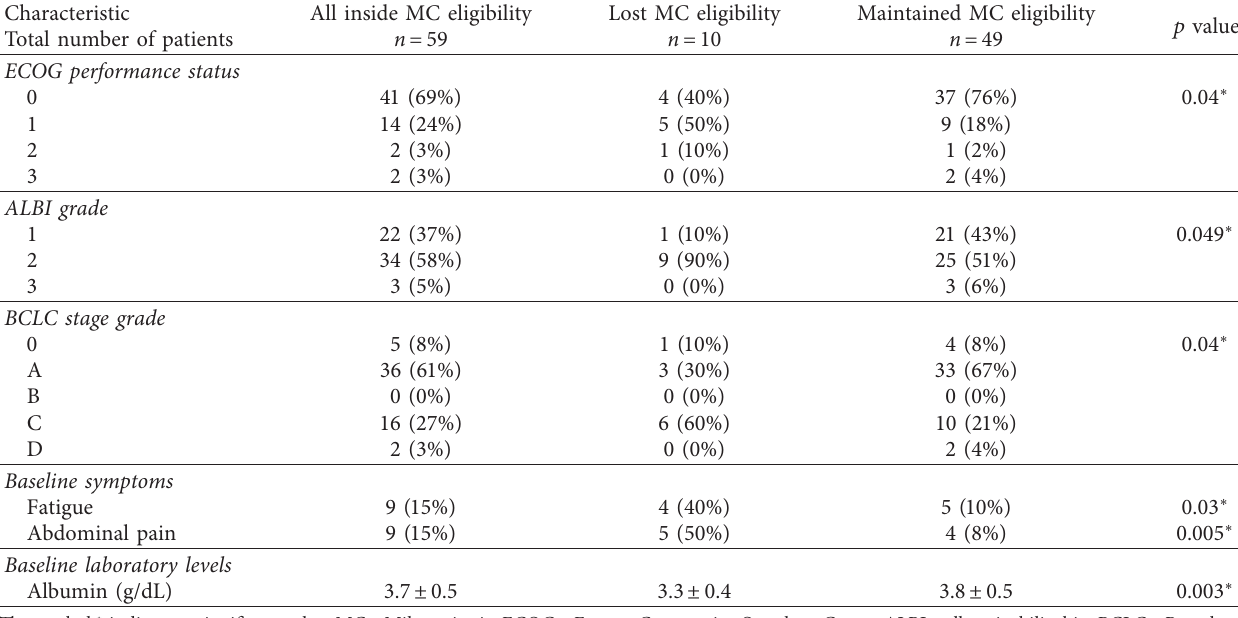
Table 4: Baseline clinical laboratory tumor characteristics of the inside Milan criteria patients: significant differences only. Characteristic